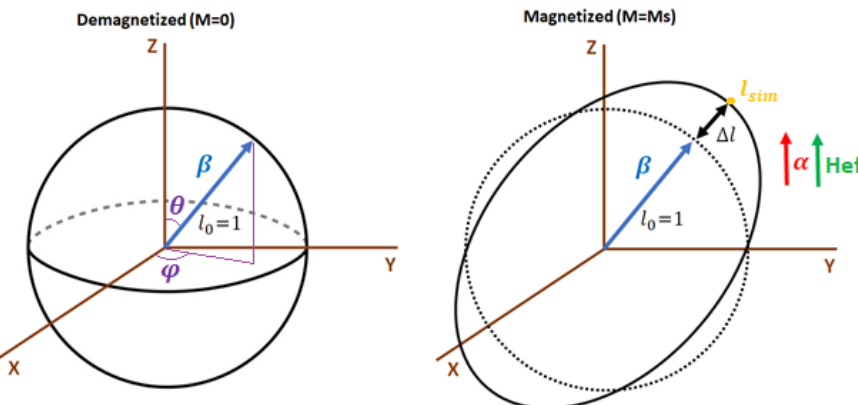
Figure 4. The Joule effect mapped to a sphere. In this model we assume that the magnetization is saturated in the direction of the effective field ( α (cid:107) H ef f ). Symbols M and M s stand for macroscopic magnetization and saturation magnetization, respectively. The dash line on the right represents the original unit sphere (demagnetized